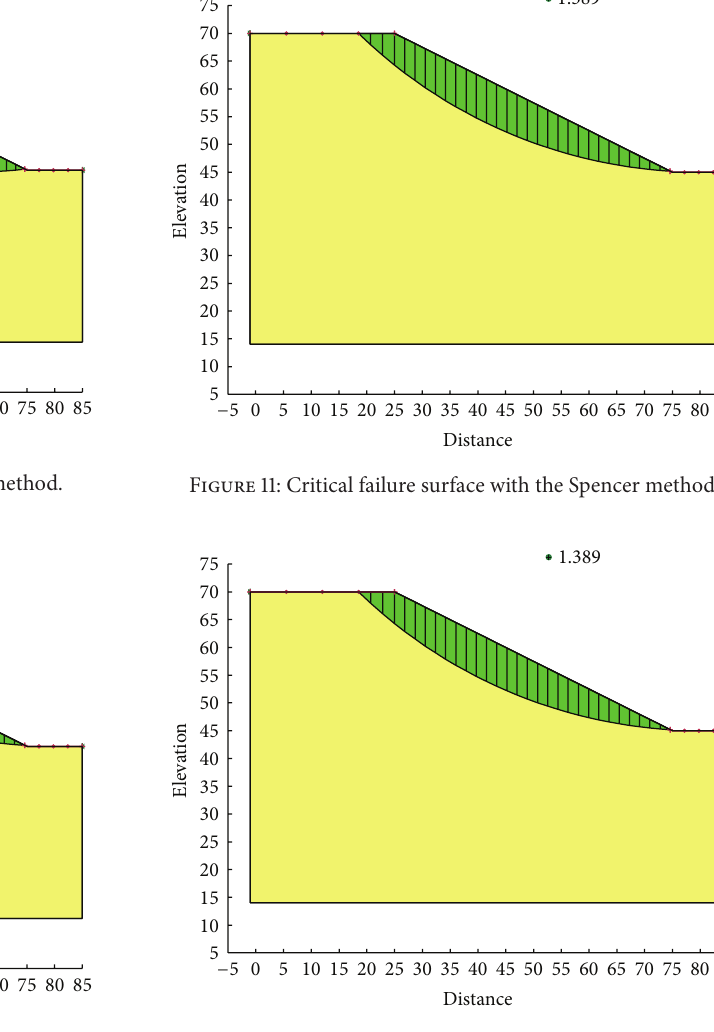
Figure12:CriticalfailuresurfacedeterminedwiththeGLEmethod.